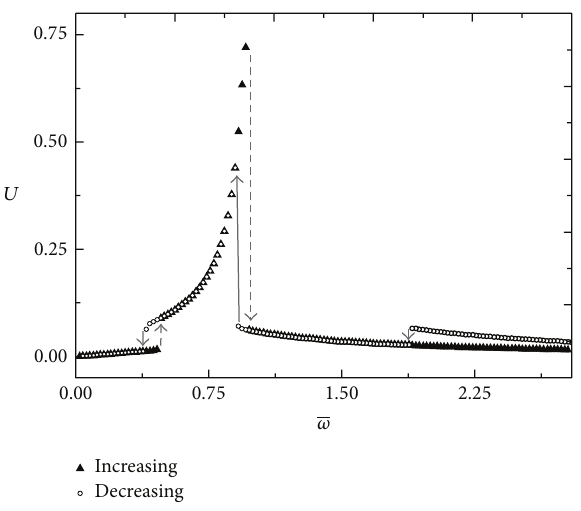
Figure 5: Maximum system amplitude with V = 0.075 m/s and increasing the forcing frequency.